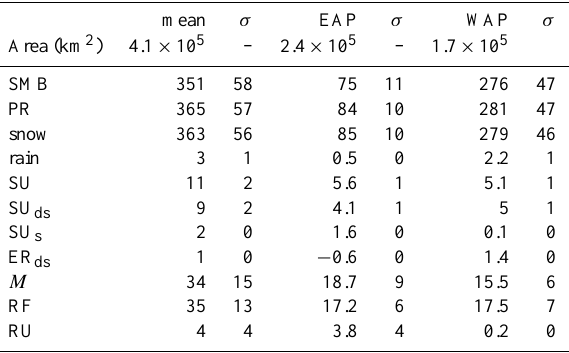
Table 1. AP integrated values of mean SMB components [Gtyr − 1 ] with interannual variability σ : total (snow + rain) precipitation (PR), snow, rain, total sublimation (SU tot ), surface sublimation (SU s ), drifting snow sublimation (SU ds ), drifting snow erosion (ER ds ), runoff (RU), snowmelt ( M ) and refreezing (RF). All val- ues are calculated for basins 24–27 of Zwally et al. (2012), over a total AP area of 4.1 × 10 5 km 2 . For WAP and EAP values, basins 24/25 and 26/27 are used, respectively. Values are calculated from yearly averages; from 2003 onwards integrated values represent the ice shelf excluding Larsen B ice shelf.